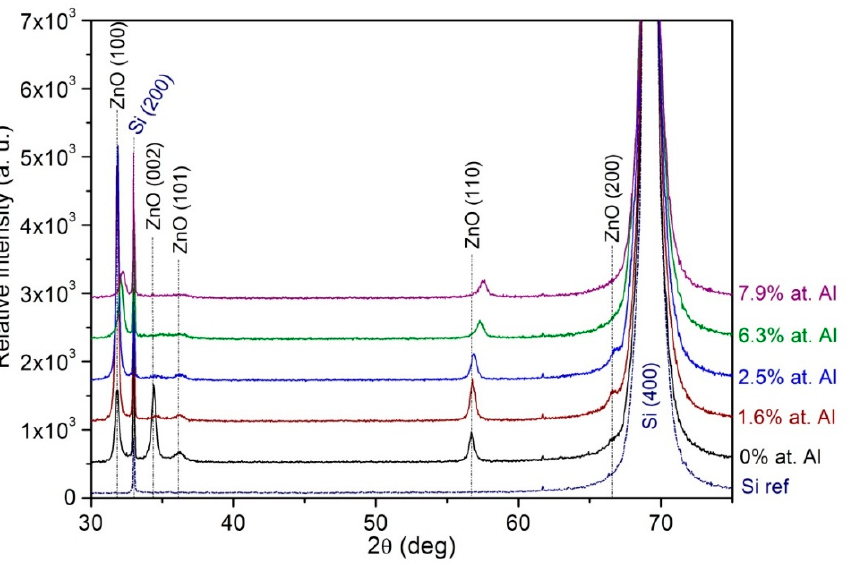
Figure 3. The XRD patterns collected for AZO films prepared with different Al concentration levels. Undoped ZnO film exhibits a hexagonal structure. The sample was polycrystalline with randomly orientated grains showing (100), (002), (101) and (110) XRD peaks, with the (002) being the strongest [31]. As we investigated previously to obtain monocrystalline films, we needed a higher growth temperature [19] and longer purging times [23]. As Al 2 O 3 interlayers were introduced (the method of doping with Al), the (002) XRD peak faded away, and the intensity of the (100) peak became dominant, with the maximum for a low Al fraction sample (1.6% Al). Evolution of ZnO peaks showed that introducing the Al 2 O 3 interlayer affected the (002) growth, and the (100) XRD peak appeared to be the preferred growth direction. Similar results were reported by us [26] and in the references [32,33] for samples grown at slightly different conditions. It seems thus that the trend reported above is common for samples with Al.